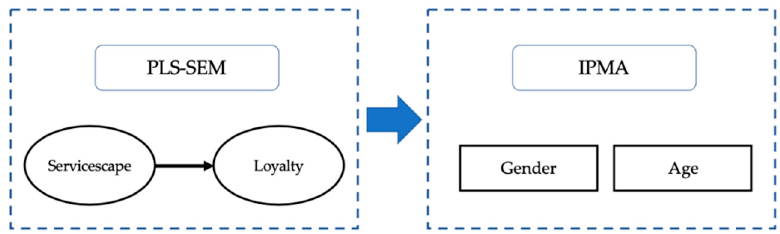
Figure 1. Theoretical framework of the study. IMPA: Importance-Performance Matrix Analysis; PLS-SEM: Partial Least Squares Structural Equations.